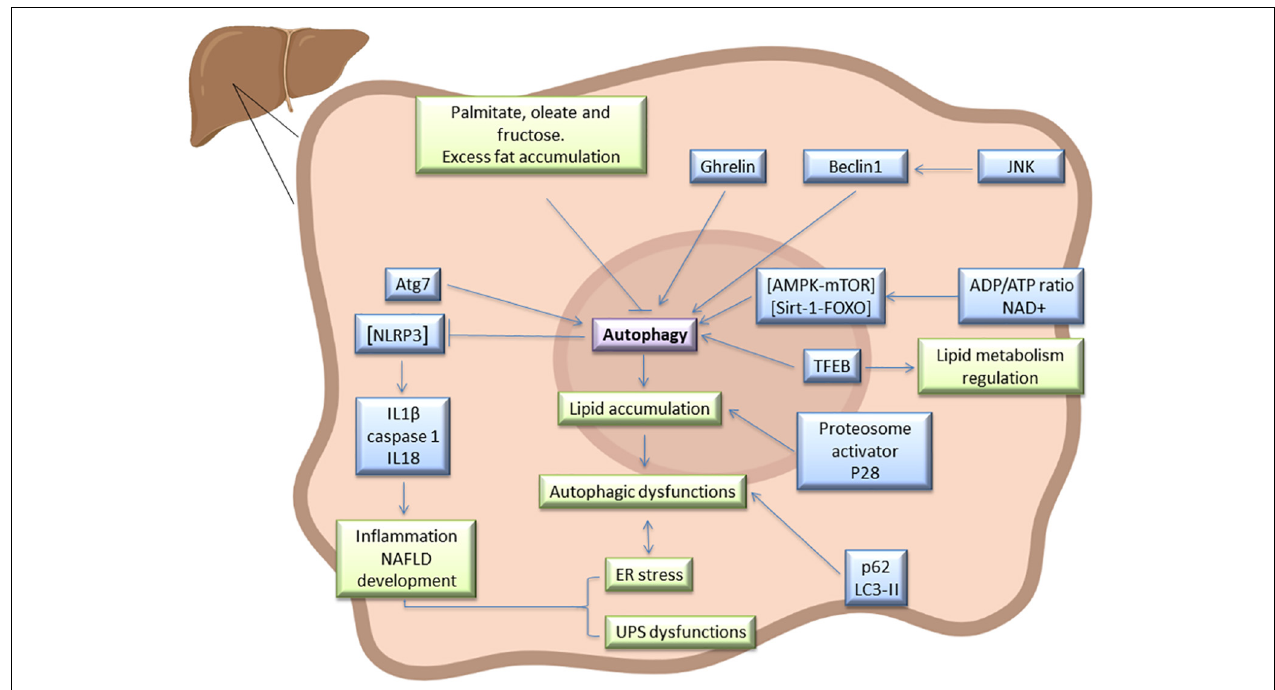
FIGURE 1 | Autophagy signaling pathway in steatotic liver. Atg7, Beclin1, LC3-II, and p62 has been described as markers of autophagy in fatty liver, and this process is regulated by AMPK-mTOR, Sirt1-FOXO, and TFEB. In this type of liver, autophagy is interrelated with UPS, ER stress, JNK, ghrelin, and NLRP3 inflammasome signaling pathways, among others. As a result of interaction between all these mediators, dysfunction in lipid accumulation and inflammation may occurs in steatotic liver. Some diet components such as excess fat, palmitate, oleate or fructose could alter hepatic autophagy in steatotic livers and therefore affect NAFLD